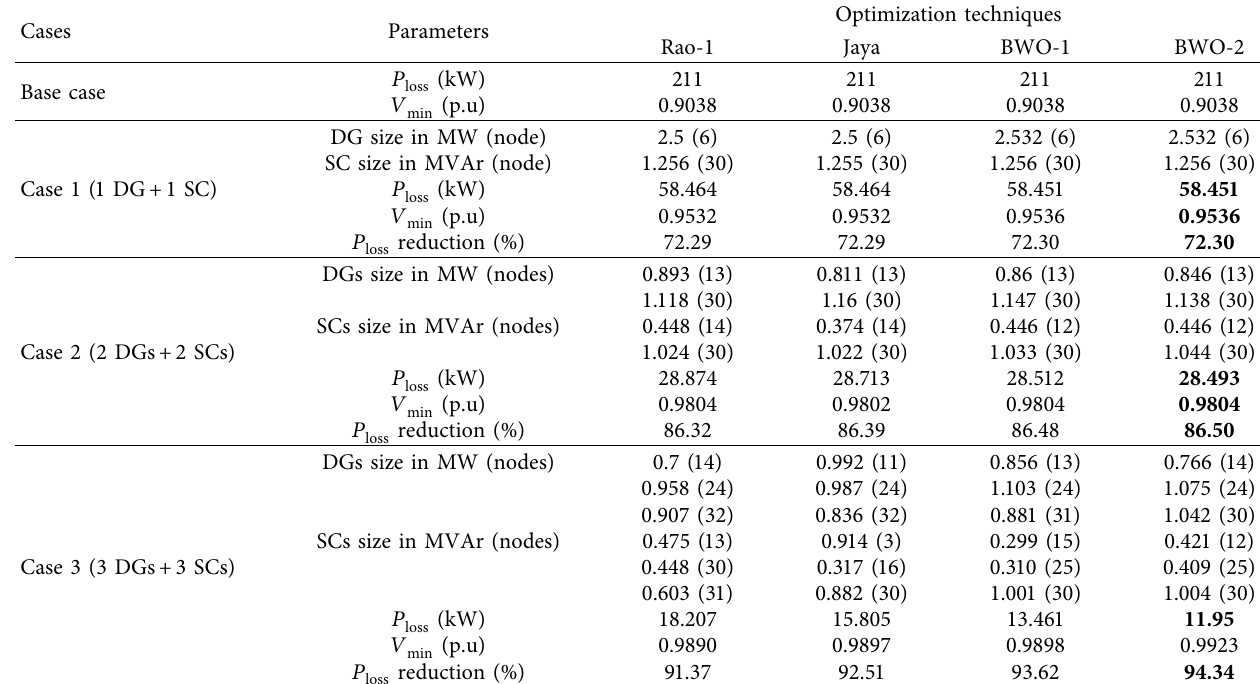
Figure 9: Single-line diagram of the standard IEEE 33-bus Table 5: Performance comparison of the Rao-1, Jaya, BWO-1, and BWO-2 for the 33-bus test system.